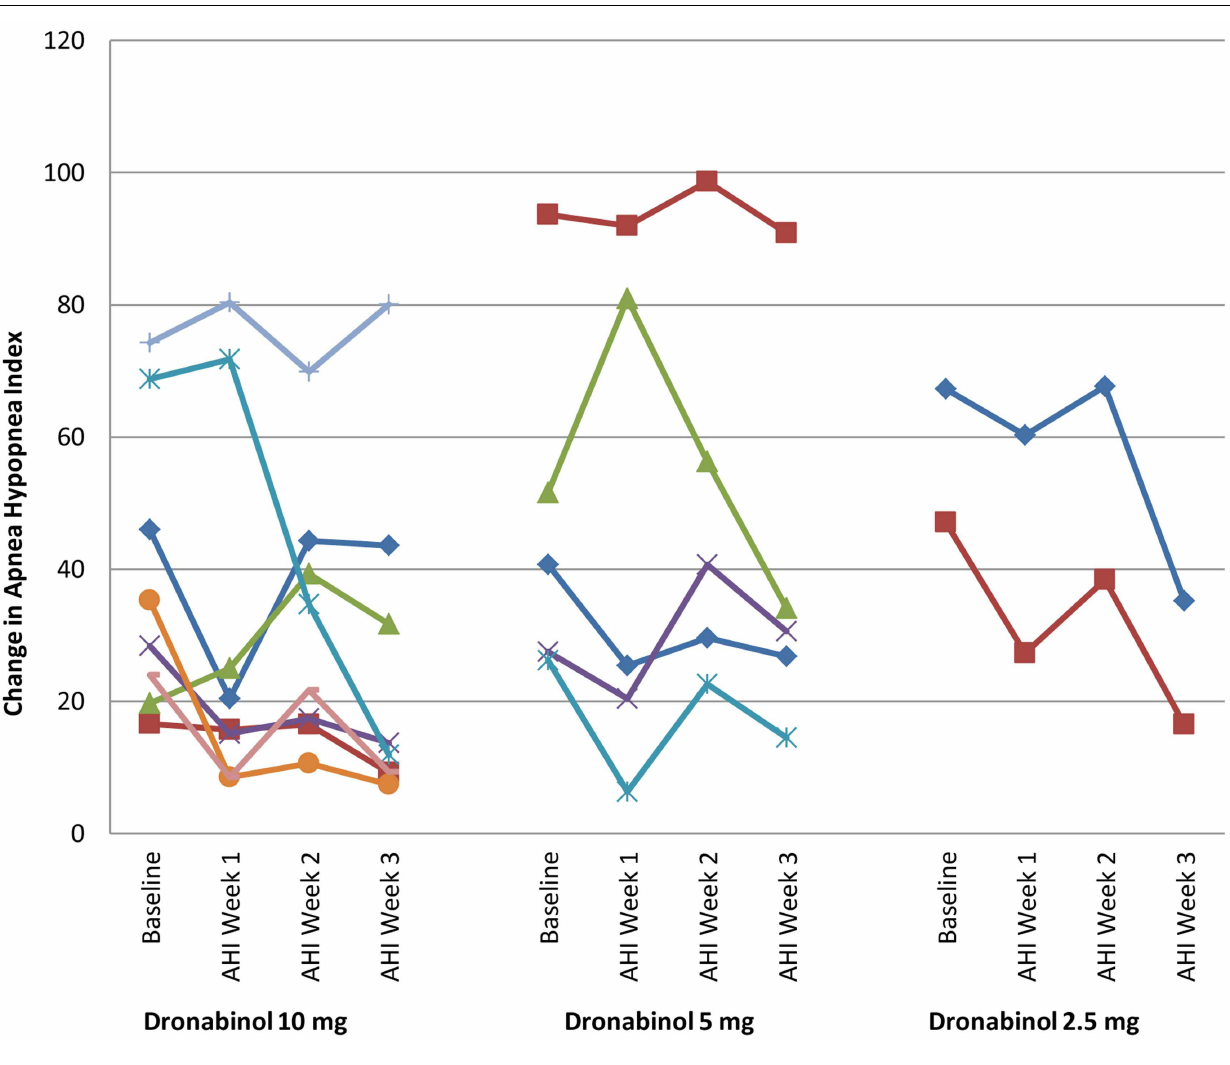
FIGURE 1 | Change in apnea hypopnea index from baseline to week